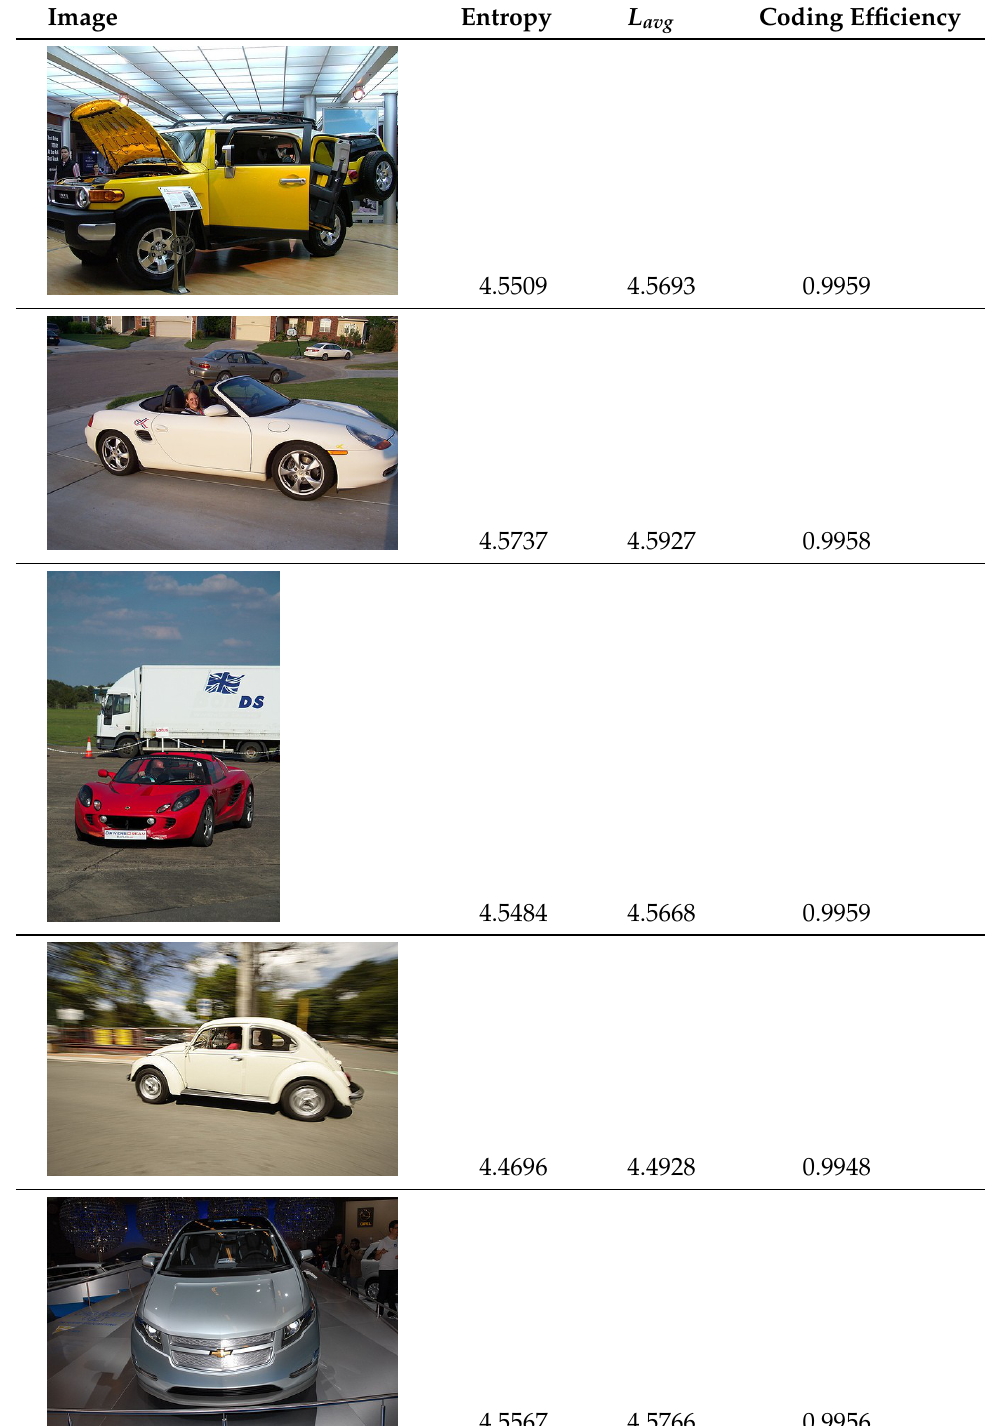
Table 5. The Huffman coding